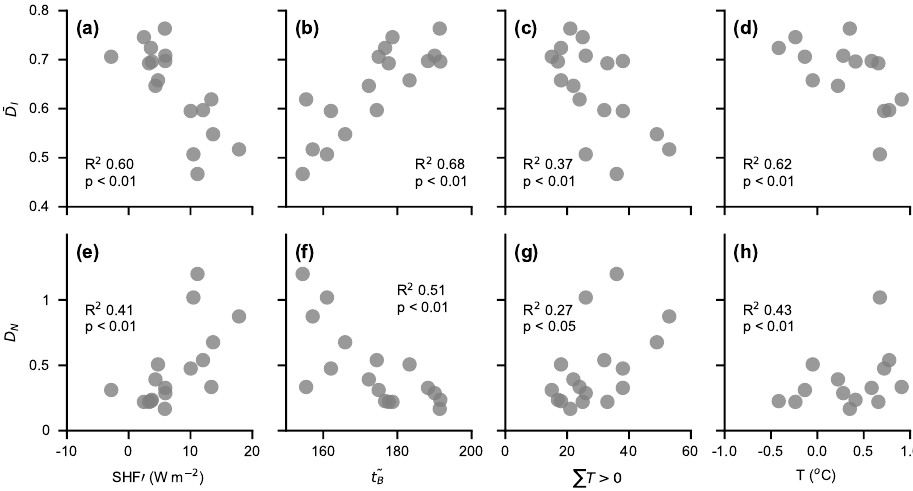
Figure 5. Relationships between meteorological indicators and dark ice intensity, D I (upper panels), and normalised darkness, D N (lower